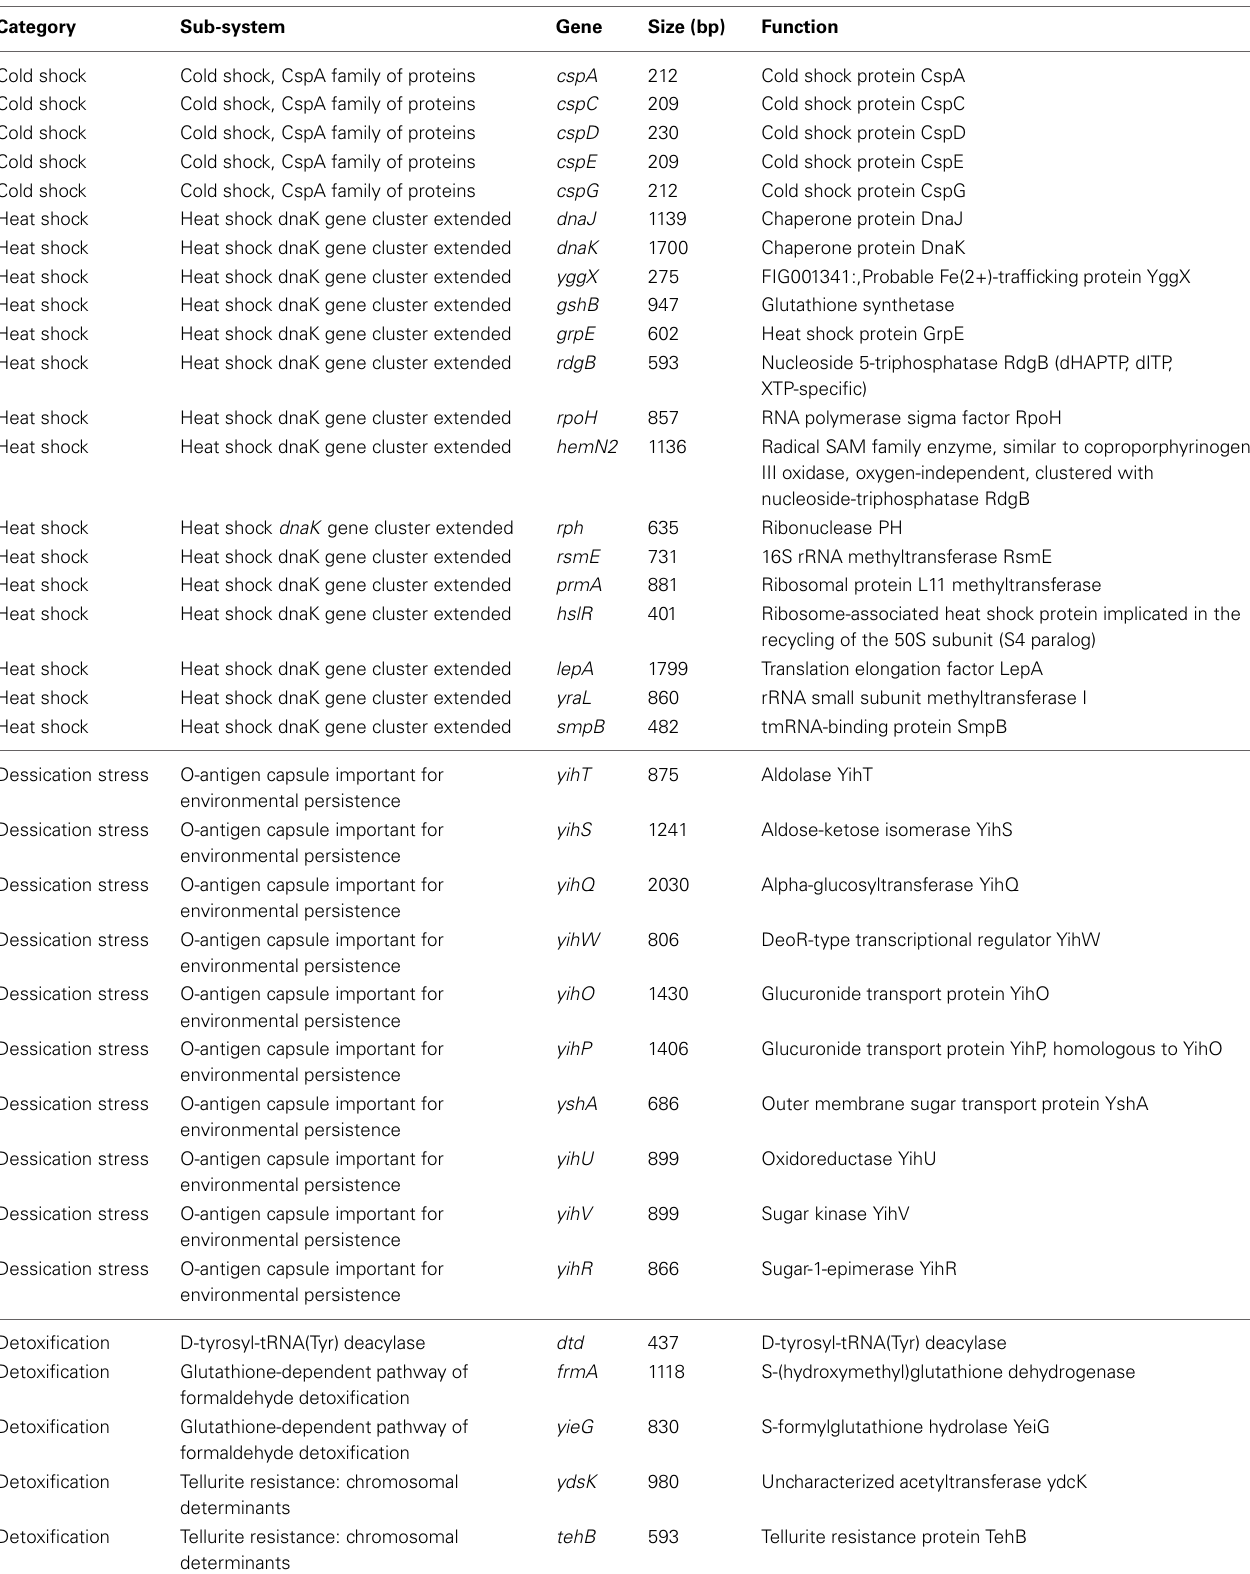
FIG001341:,Probable Fe(2+)-trafficking protein